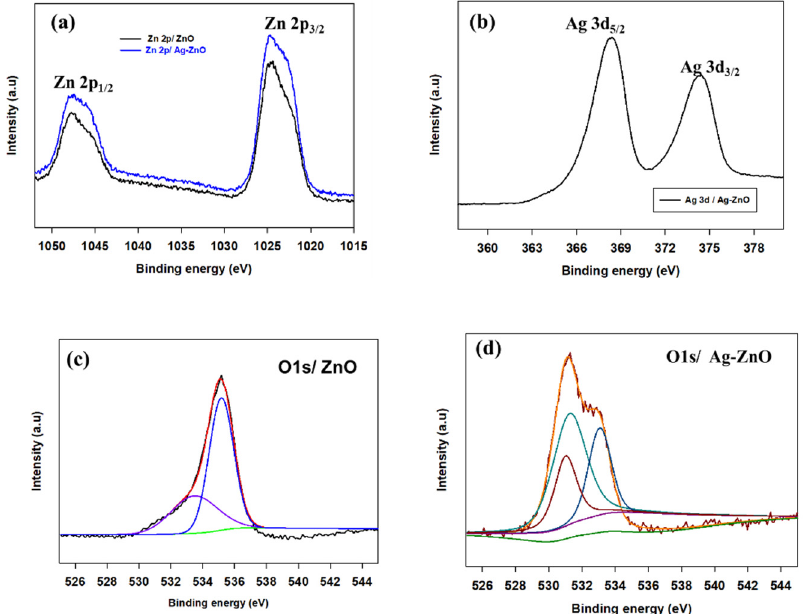
Figure 4. High resolution spectrum of ( a ) Zn 2p, ( b ) Ag 3d, ( c ) O1s from ZnO, and ( d ) O1s from Ag-ZnO.